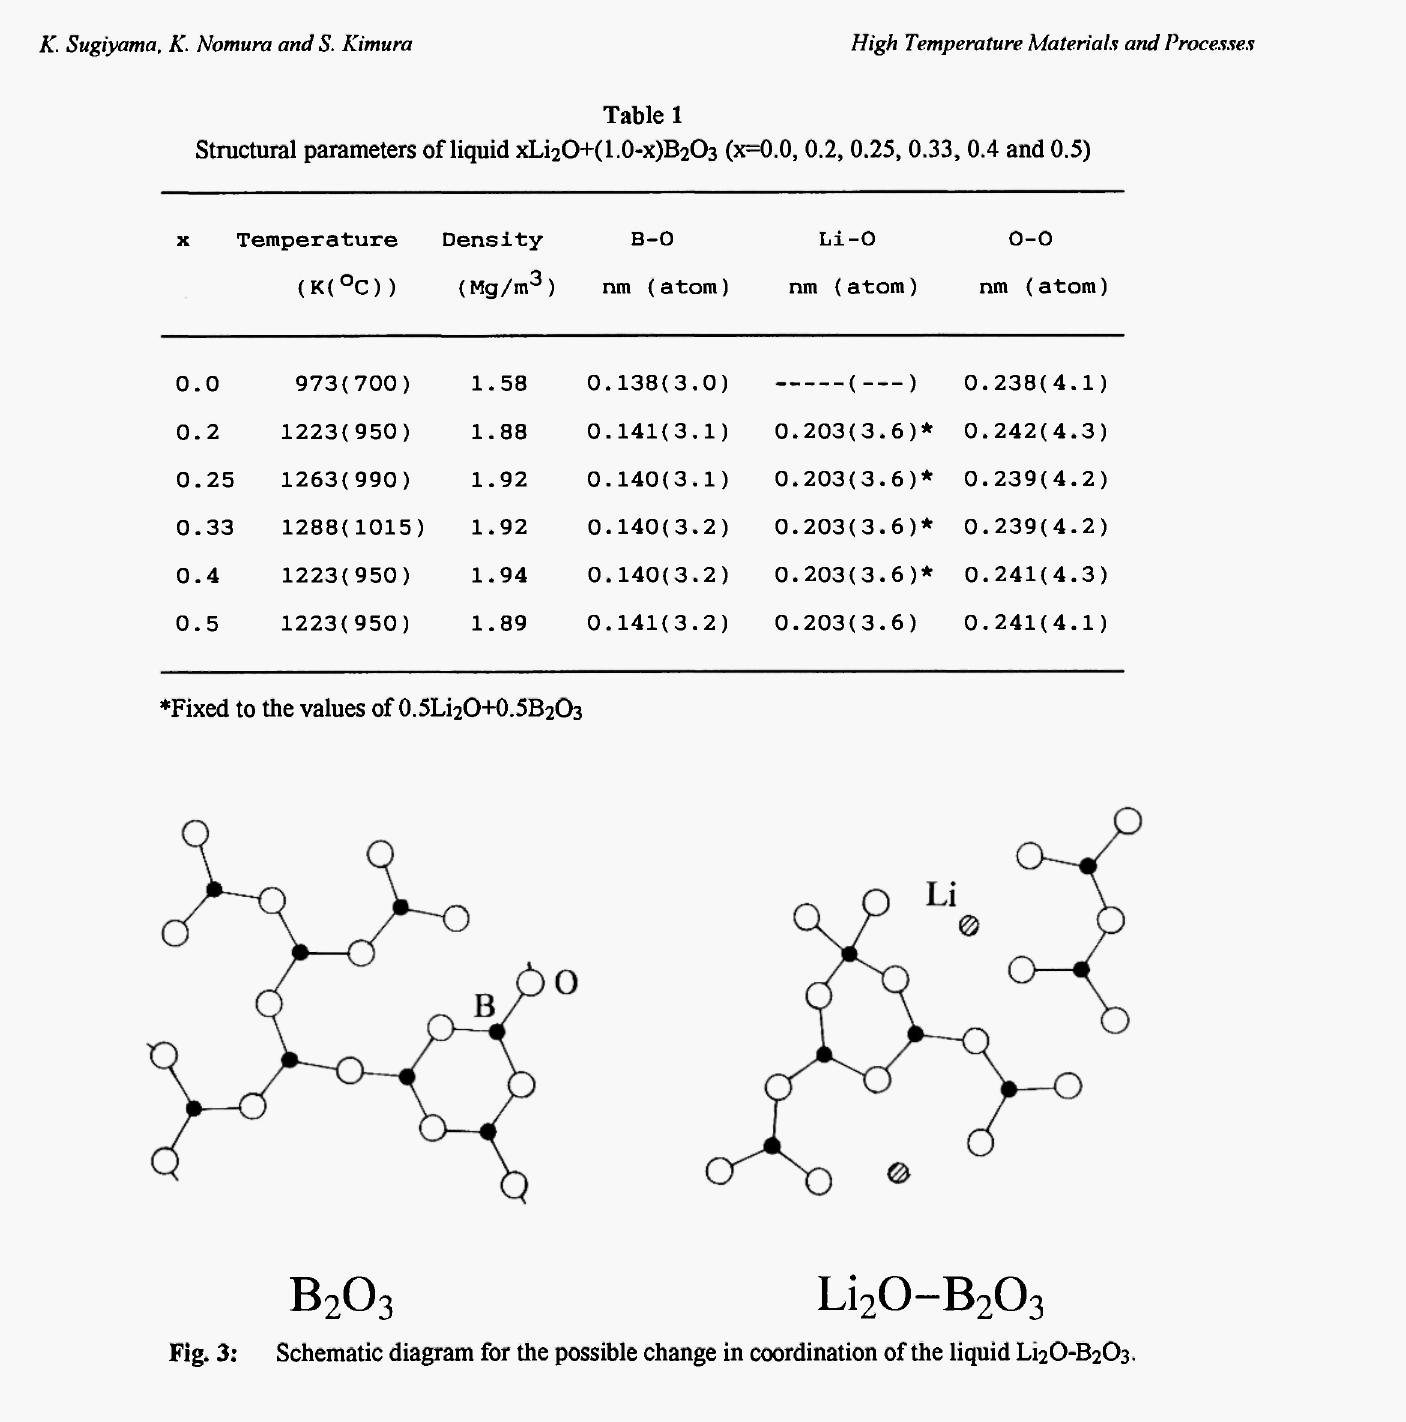
of tetrahedral coordination around boron in the composition region to be around 30 to 40 mol%Li This conclusion for the tetrahedral coordination of oxygens around boron is consistent with the present results of the liquid Li 0-B C>3 2 2